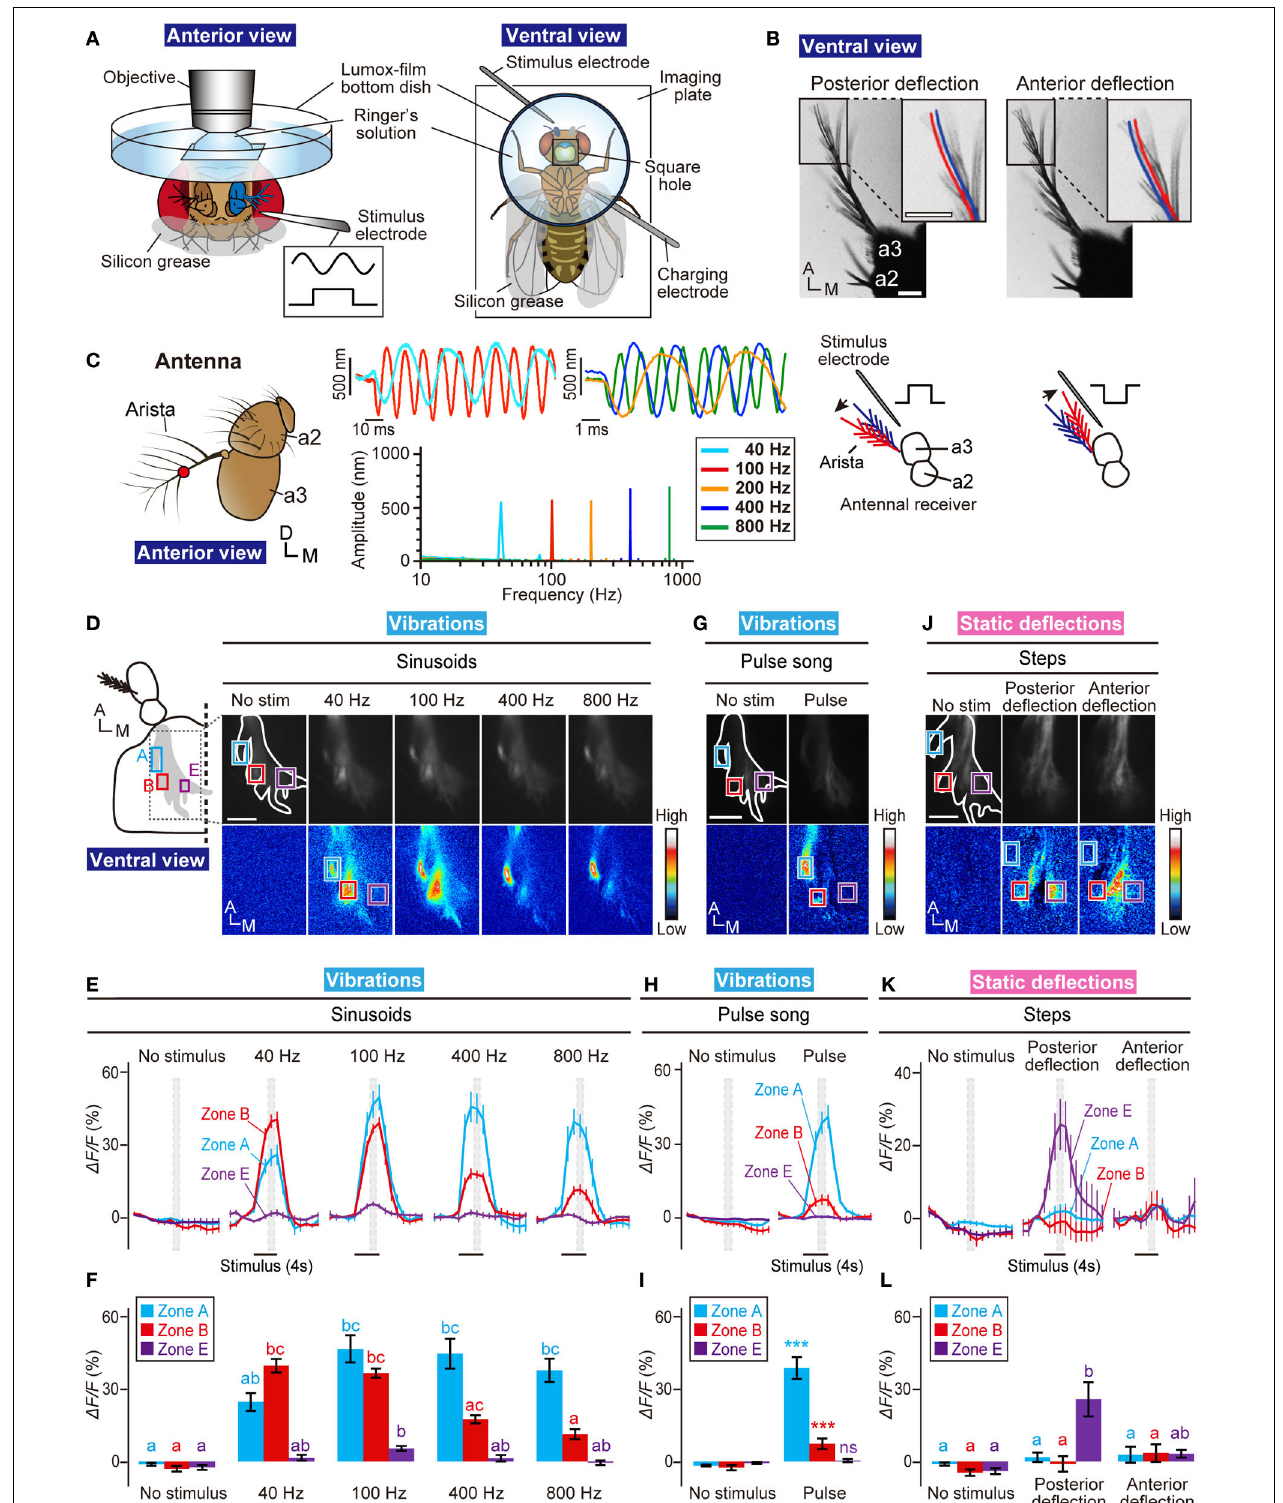
FIGURE 2 | Calcium imaging for the AMMC zones. (A) Fly preparation to monitor calcium responses in the AMMC. A fly expressing GCaMP3 protein was fixed on a stage of a laser-scanning microscope. (B) Actuation of the antennal receiver. Stimulus of an electrostatic force with a positive step